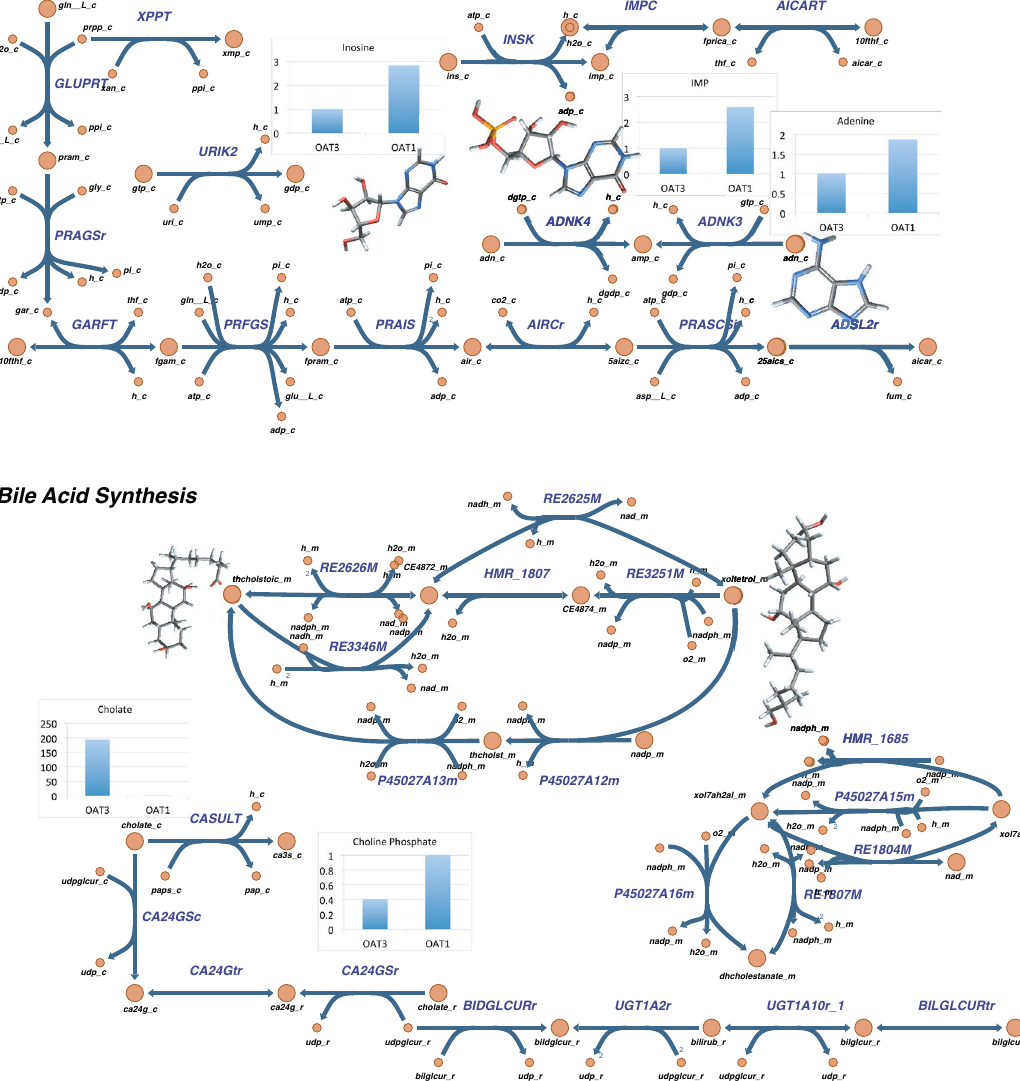
Figure 6. Highlight of reactions in Purine Synthesis (OAT1, Table 1) and Bile Acid Synthesis (OAT3, Table 1). Purine Synthesis : Reactions in the Purine Synthesis pathway that are not present in OAT1 WT models but are present in OAT1 KO are outlined. Fold change ratios of particular metabolites that were increased in OAT1 KO are presented next to their 3D bond-line molecular structures and include adenine, inosine, and IMP. Bile Acid Synthesis : A subset of the reactions that are present in the OAT3 knockout, but not the WT, are highlighted. Since the plasma concentration of choline is significantly higher in the OAT3 knockouts, the model pathways directly involving choline and choline-phospholipids were not increased (gray-shaded/opacified pathway at the base of the figure). Consistent with experimental data, however, pathways and metabolites with more complex, ring containing structures were identified in the OAT3 KO, including xoltetrol_m (3α,7α,12α,26-Tetrahydroxy- 5β-cholestane) and thcholst_m (3α, 7α,